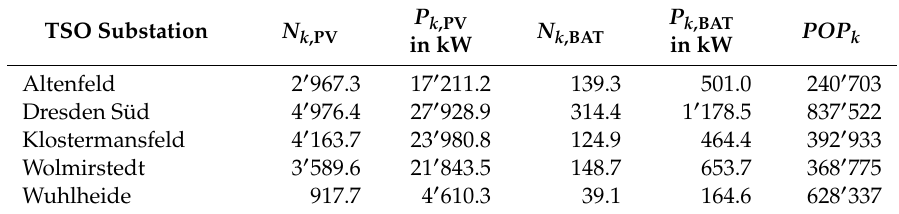
Table 2. Photovoltaic (PV) and battery storage (BAT) parameters determined by TSO substation